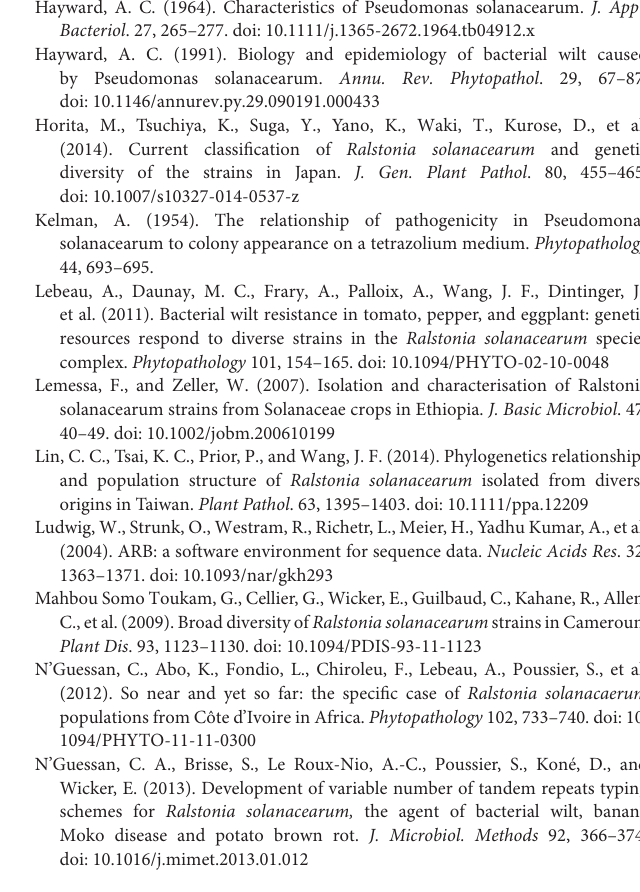
Table S1 | Ralstonia solanacearum strains isolated from Mayotte Island. a Mayotte location and area of strain isolations (C, Centre; N, North ; NE, Northeast; S, South; SE, Southeast). ∗ Strain used for the virulence tests. Table S2 | RSSC reference strains used in this study to structure the phylogenetic tree. Table S3 | Tomato accessions used for the virulence tests. Table S4 | Sequevar distributions of the Ralstonia solanacearum phylotype I strains within the five vegetable production areas of Mayotte. Table S5 | Sequevar distributions of the Ralstonia solanacearum phylotype I strains within the different host species sampled in Mayotte. Table S6 | Comparison table of the mean wilted rate of several tomato lines from the Core collection measured under field and controlled conditions